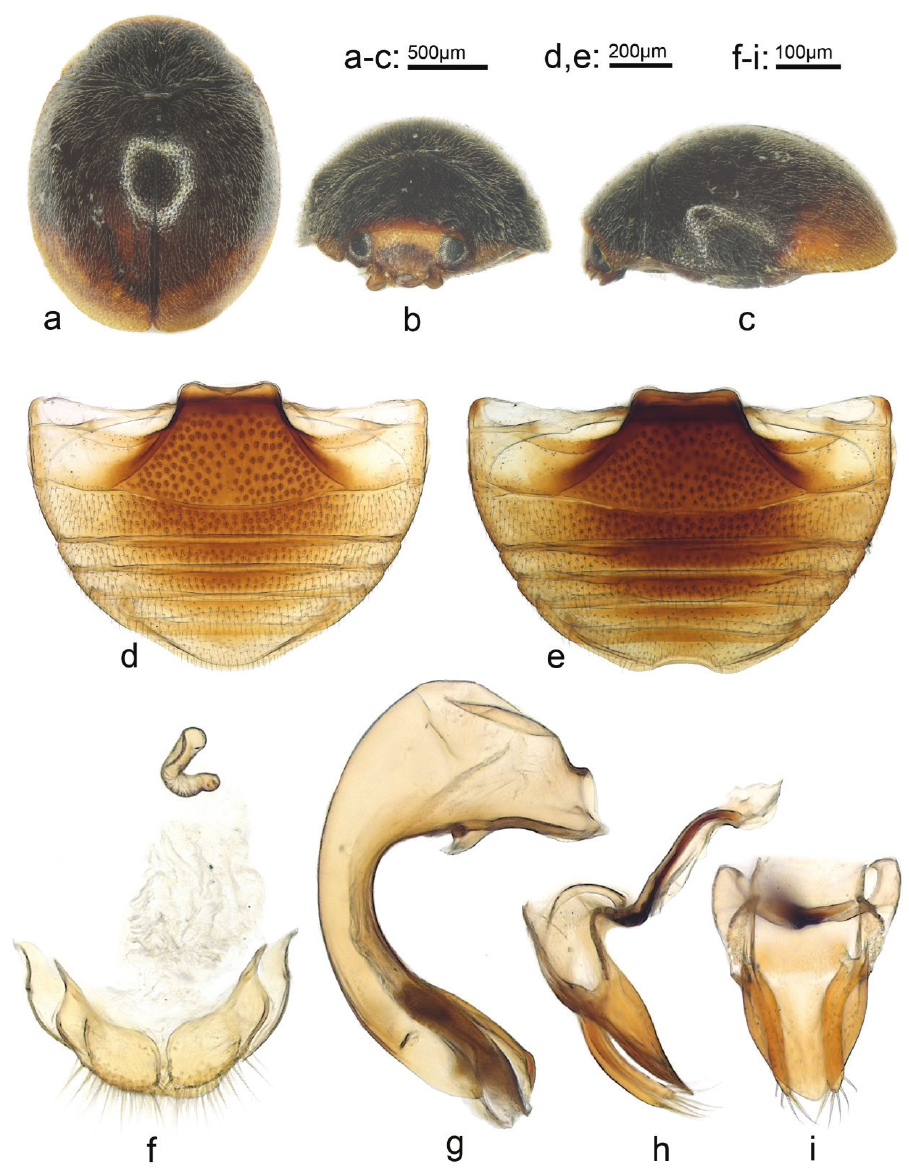
Figure 1. Pseudaspidimerus palatus Huo & Wang sp. n. a dorsal view b frontal view c lateral view d female abdomen e male abdomen f female genitalia g penis h lateral view of tegmen i ventral view of tegmen.